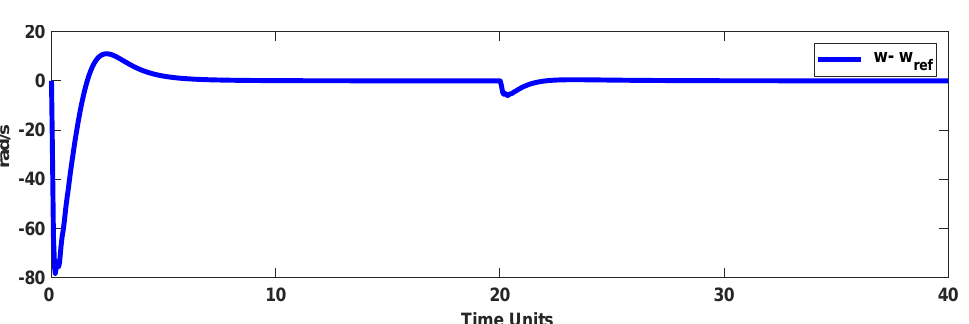
Figure 9. Rotor speed in the faulty condition.